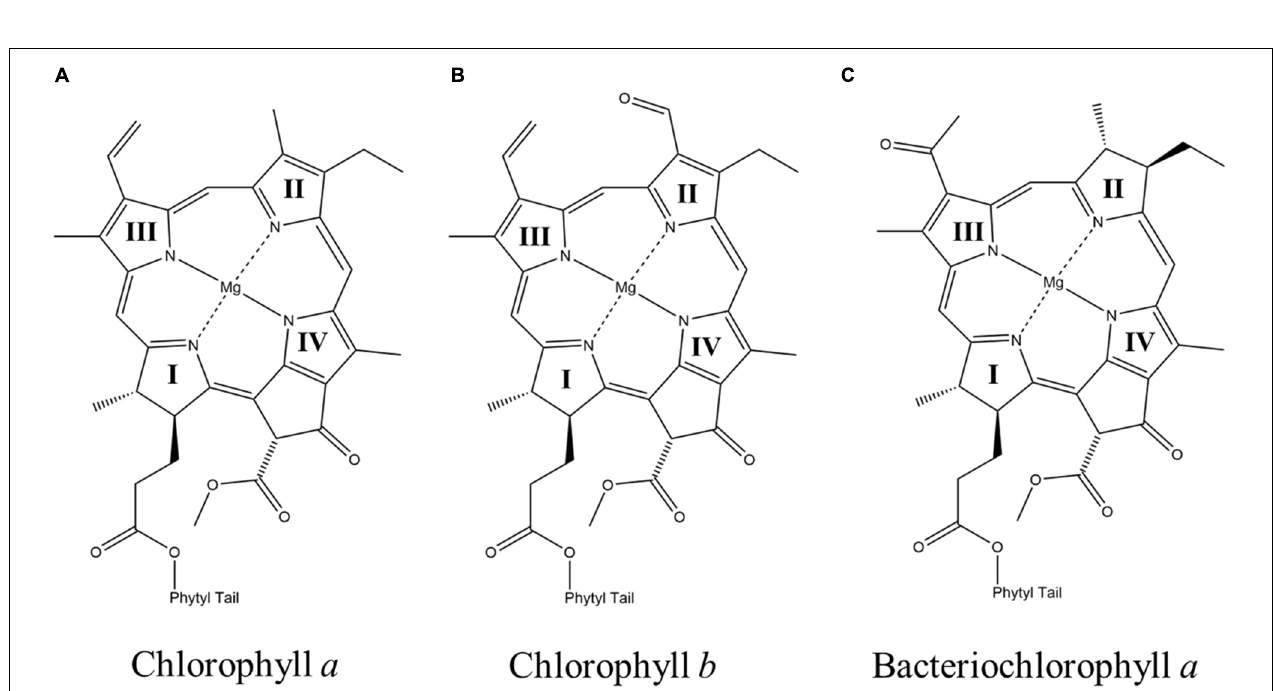
FIGURE 2 | The chemical structures of (A) chlorophyll a (Chl a ) (B) chlorophyll b (Chl b ), and (C) bacteriochlorophyll a (BChl a ). The nitrogen atoms of the four pyrrole rings in each macrocycle are labeled as I, II, III, and IV, respectively.